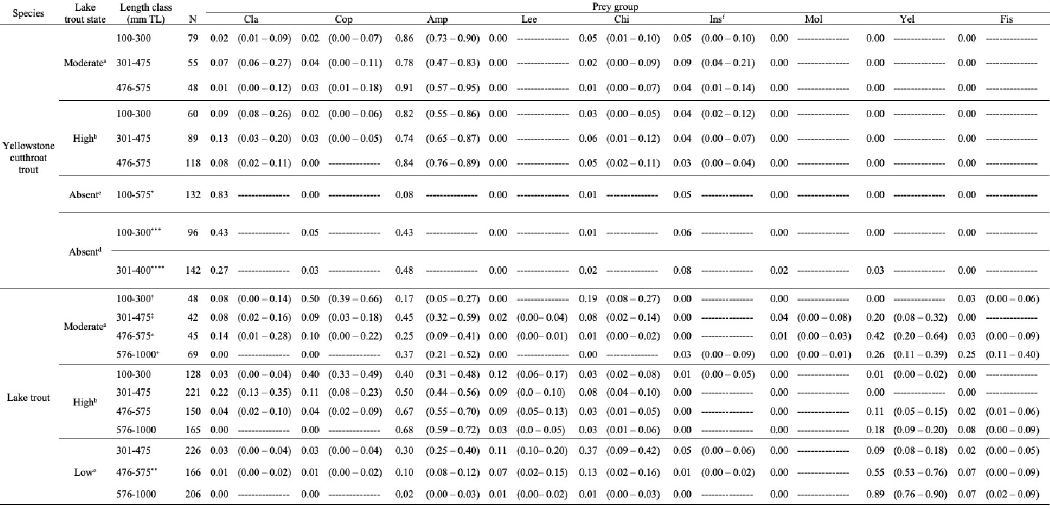
Fig 4. Comparisons of diet proportions. Diet composition (proportion by weight) for Yellowstone cutthroat trout and lake trout in Yellowstone Lake (Cla = cladocerans; Cop = copepods; Amp = amphipods; Lee = leeches; Chi = chironomids; Ins = insects; Mol = mollusks; Yel = Yellowstone cutthroat trout; Fis = unidentified fish). Bootstrapped 95% credible intervals were drawn from a distribution of 1000 samples. Relative abundances of lake trout are from Syslo et al. [55], where absent is a state with no detectable density or complete absence of lake trout (1989), low-density state is ~80,000 > 300 mm lake trout (1997), high-density state is ~450,000 > 300 mm lake trout (2012), and moderate-density state is ~300,000 > 300 mm lake trout (2019). No Yellowstone cutthroat trout diets were analyzed during the lake trout low-density state. a Current study. b Syslo et al. [53] averages among stratification seasons. c Jones et al. [46]. d Benson [44]. e Ruzycki et al. [54]. f Includes Ephemeroptera, Tricoptera, Plecoptera, and non-chironomid dipterans. � Not included in table are diet items and proportions: 0.01 Leucisids, 0.02 organic matter. † Not included in table are diet items and proportions: 0.01 diatoms, 0.02 detritus. ‡ Not included in table are diet items and proportions: 0.03 diatoms, 0.01 detritus. ± Not included in table are diet items and proportions: 0.01 diatoms, 0.03 detritus. + Not included in table are diet items and proportions: 0.06 diatoms, 0.03 detritus. �� Not included in table are diet items and proportions: 0.04 lake trout eggs, 0.01 sucker. ��� Not included in table are diet items and proportions: 0.01 wasps and beetles, 0.01 water mites. ���� Not included in table are diet items and proportions: 0.03 wasps and beetles, 0.02 water mites, 0.02